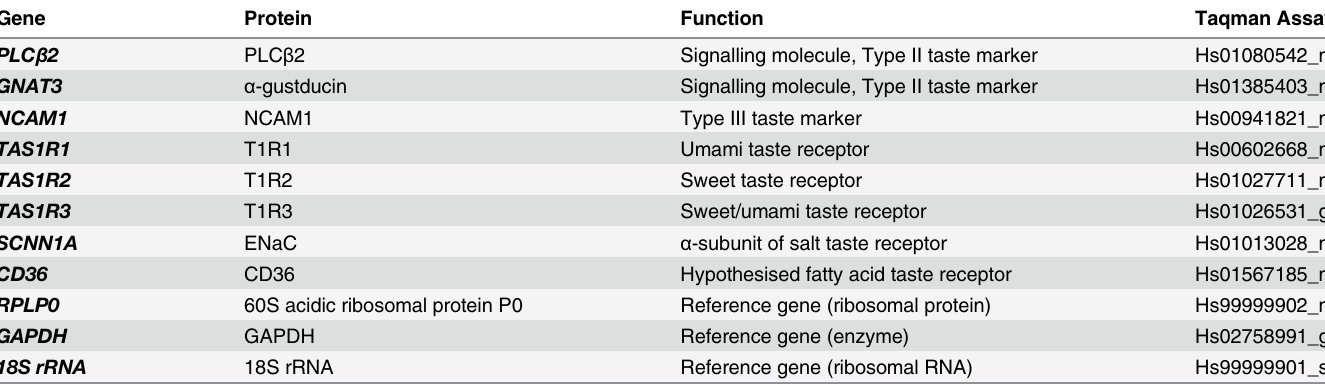
Table 1. Taste genes analysed by quantitative real-time PCR (Taqman assay).